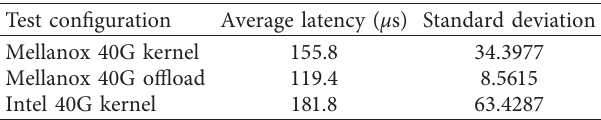
Table 10: System 3: latency results per NIC configuration.